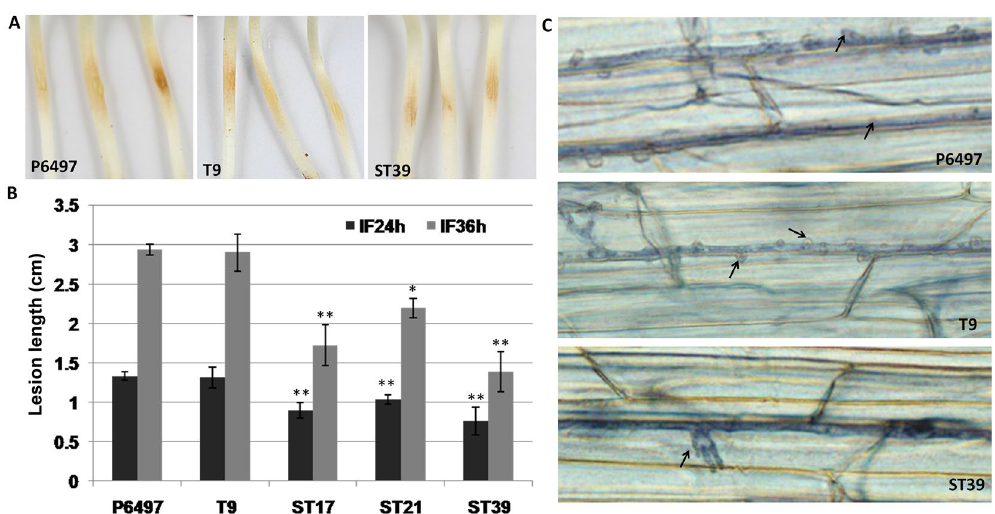
Figure 9. PsAtg6a silencing reduced P . sojae virulence. ( A ) Phenotypes of soybean etiolated seedlings inoculated with wild-type P . sojae and recombinant strains. Approximately 250 zoospores were used for each inoculation. Photographs were taken 24 and 36 hpi. The edges of the lesions are indicated by arrows. ( B ) Lesion lengths measured at 24 hpi and 36 hpi on five seedlings in each of four independent experiments. The bars indicate the standard errors. ** P < 0.01, * P < 0.05 ( t -test). (C ) Trypan blue staining of hyphae infecting soybean epidermal cells. Photographs were taken at 30 hpi. Black arrows: